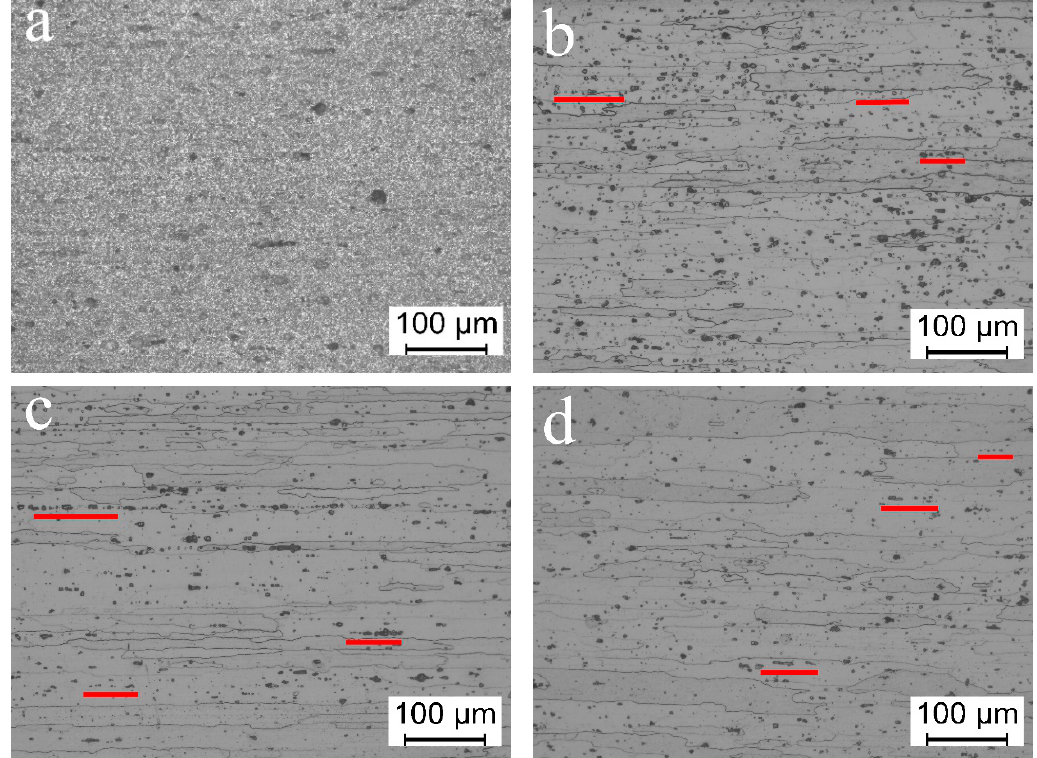
Figure 2. Longitudinal section optical microstructures of the 7075 Al sheets subjected to an aging temperature of 140 °C for different durations: ( a ) cold rolling state, ( b ) 8 h, ( c ) 16 h one-step aging, and ( d ) DA (3 h at 120 °C and 3 h at 160 °C) treatments; horizontal line represents the rolling direction.